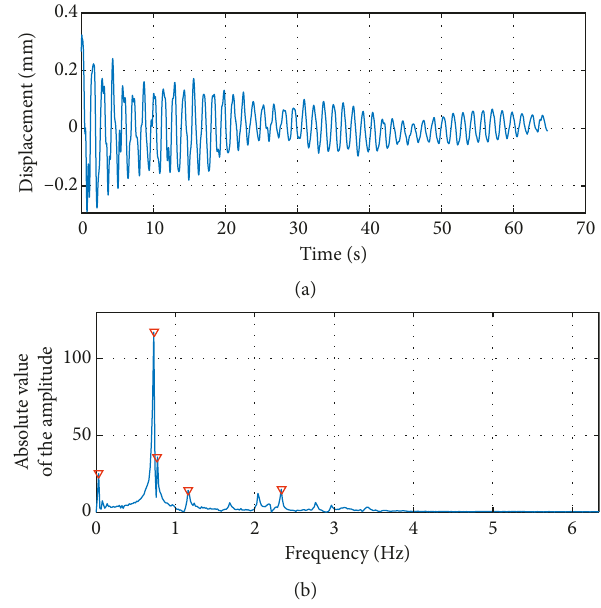
Figure 2: Example of time series and its amplitude spectrum (reproduced from [24], under the Creative Commons Attribution- NonCommercial 4.0 International License).